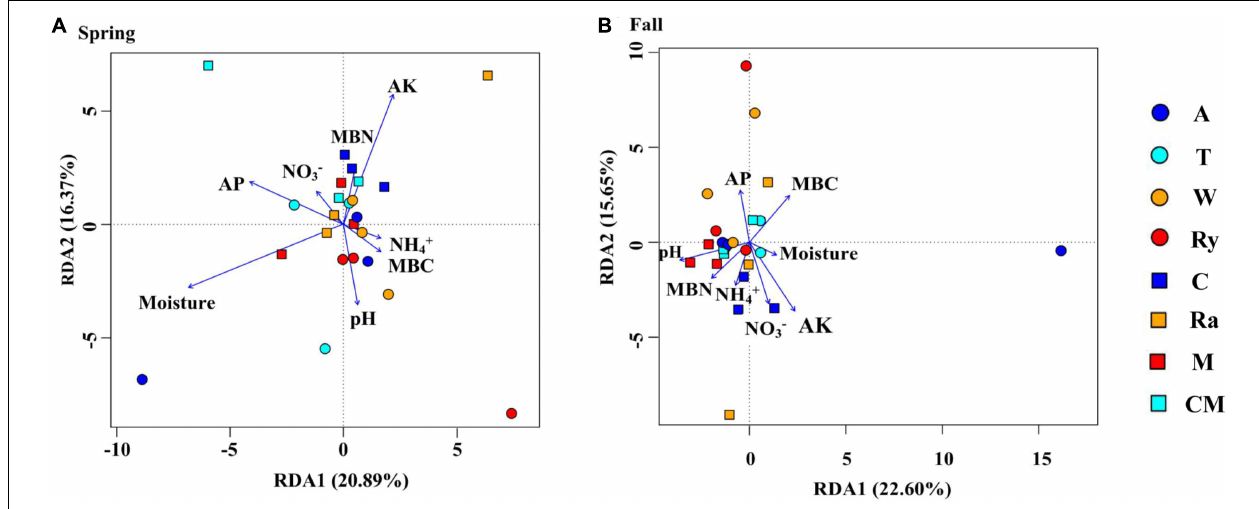
FIGURE 7 | Redundancy analysis (RDA) showing correlations between soil diazotrophic communities and soil environmental factors during the (A) Spring and (B) Fall cropping seasons in the control (CM), alfalfa (A), trifolium (T), wheat (W), chrysanthemum (C), rye (Ry), mustard (M), and rape (Ra) intercropping systems. TABLE 4 | Monte Carlo permutation test of environmental factors and soil diazotrophic community composition. Variable S